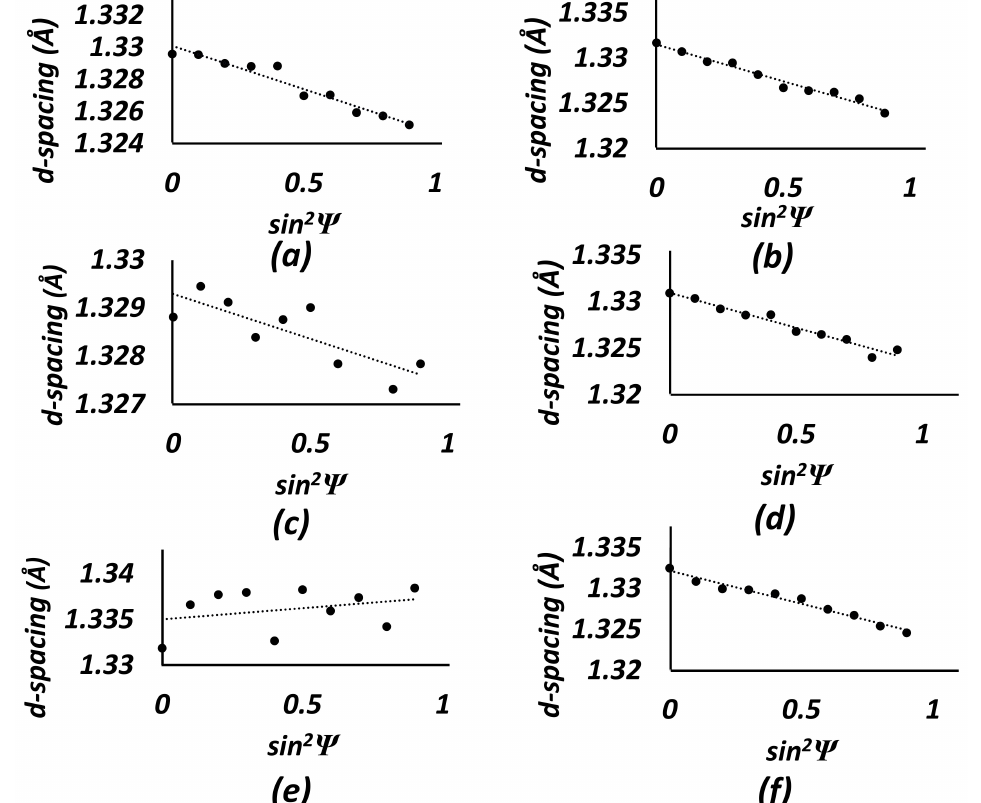
Figure 5. Plot of d-spacing vs. sin 2 ψ of: (a) 0 ◦ top surface before bead blasting; (b) 0 ◦ top surface after bead blasting;(c) 30 ◦ top surface before bead blasting; (d) 30 ◦ top surface after bead blasting; (e) EDM surface before bead blasting; (f) EDM surface after bead blasting.